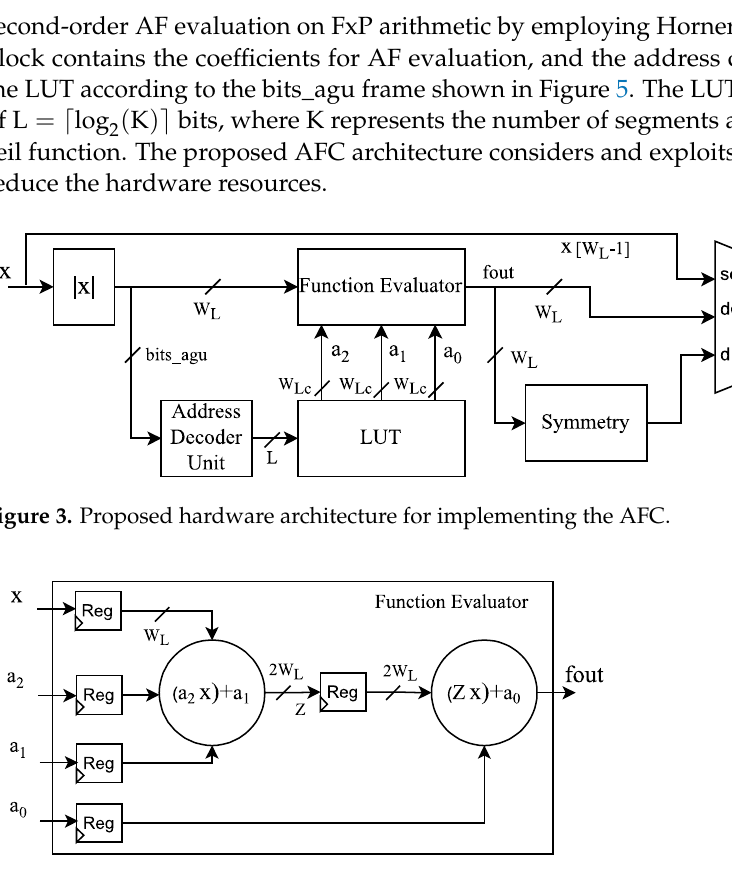
Figure 4. Function evaluator for the implemented AFC.